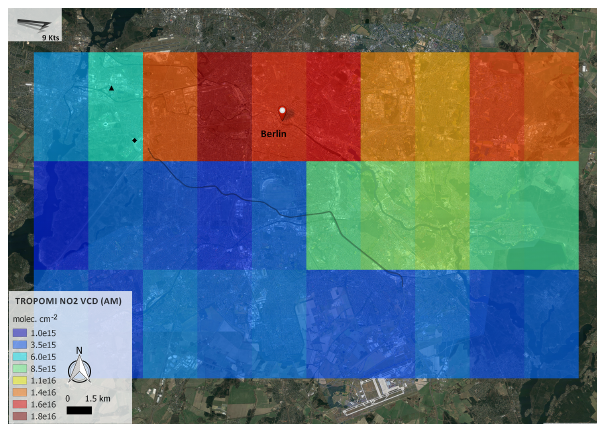
Figure 20. Tropospheric NO 2 VCDs retrieved from AirMAP for the morning flight over Berlin on 21 April 2016 (Google, TerraMet- rics) and gridded at the spatial resolution of the TROPOMI space- borne instrument (3.5 by 7km 2 ). The key contributing NO 2 emis- sion sources are indicated by a black triangle (power plant Reuter West) and black diamond (Messe Berlin). The highways A100 and A113, running south of the city, are marked by the grey line. Hourly averaged wind vectors indicate the surface wind at 08:00 (light grey, 3.3ms − 1 ), 09:00 (grey, 4.9ms − 1 ), and 10:00 (black, 5.1ms − 1 ) UTC. The average surface wind speed is indicated on the maps. A pattern of enhanced NO 2 with clear gradients can be observed, orig- inating from the Berlin city region. However, the two main west– east-oriented plumes cannot be spatially resolved anymore at the spatial resolution of TROPOMI. Note as well that only a slight NO 2 enhancement is observed for the pixel containing the main sources, i.e. the power plant Reuter West and Messe Berlin. The plumes are narrow and confined close to the source and the particular pixel con- tains a considerable number of background values smoothing out the elevated levels of NO 2